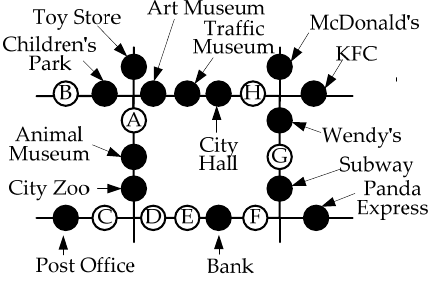
Figure 1. An example explaining the proposed problem.